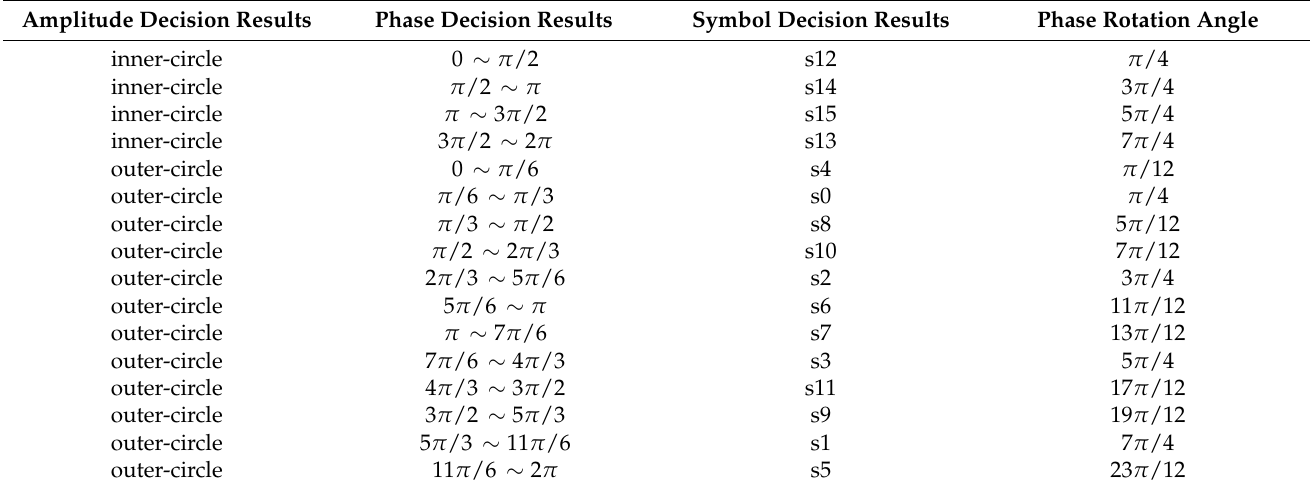
Table 1. Symbol decision and phase rotation angle rules of phase discriminator used in decision feedback loop.